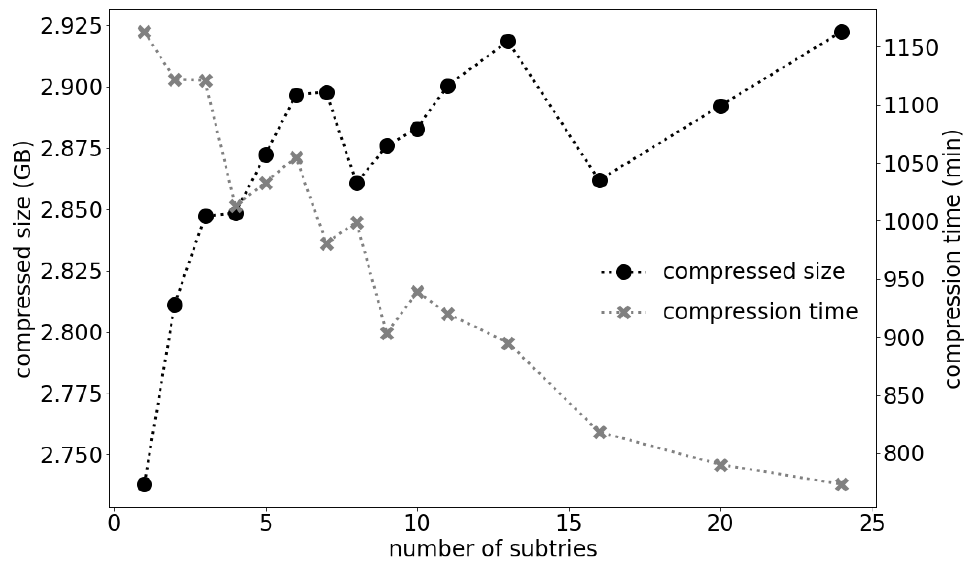
Figure 1. The compression efficiency and processing time as the functions of the number of subtries. The dataset is a 16.1 GB large excerpt from a paired end H.sapiens2 dataset. Processing in multiple subtries was obtained by imposing the appropriate memory restraints using the -F option in the command